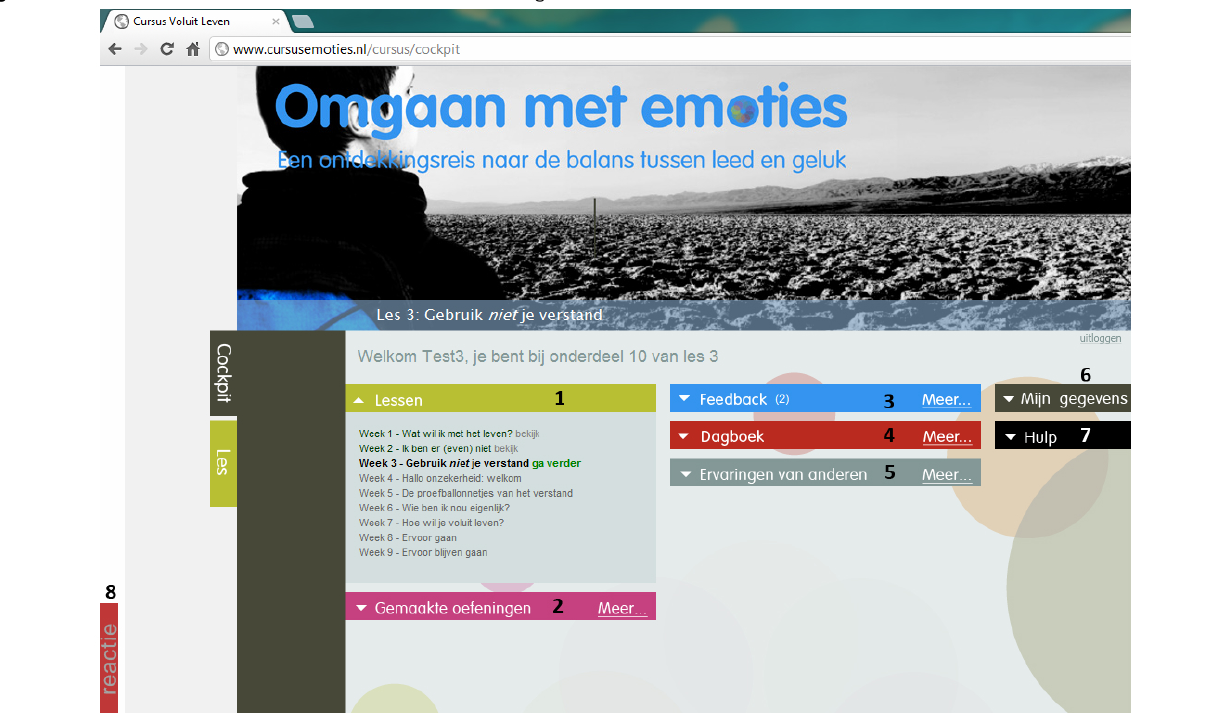
Figure 1. The home screen of the Web-based intervention "Living to the